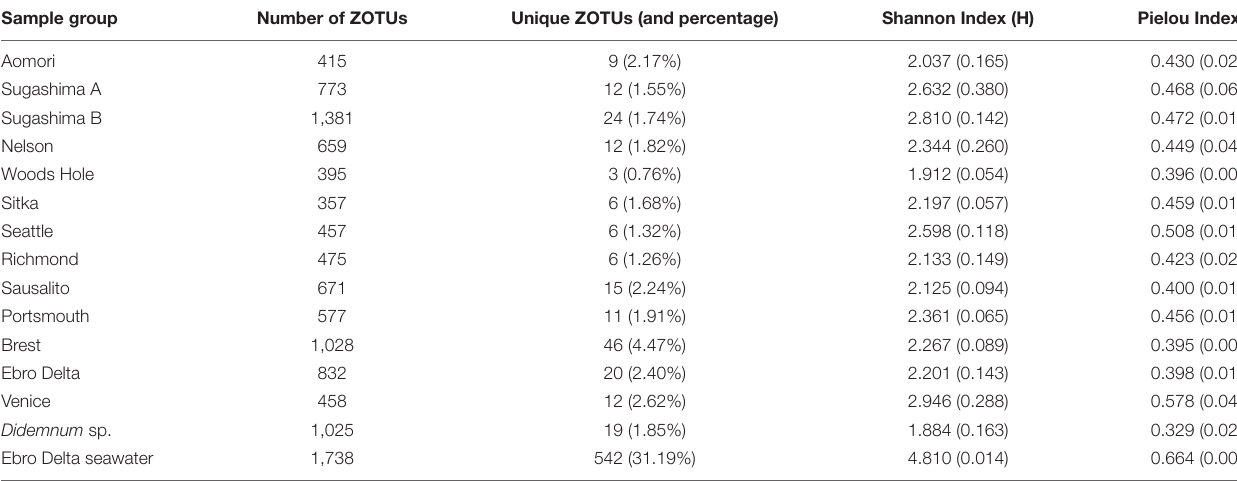
TABLE 2 | Microbial diversity per sample group. Sample group Number of ZOTUs Unique ZOTUs (and percentage) Shannon Index